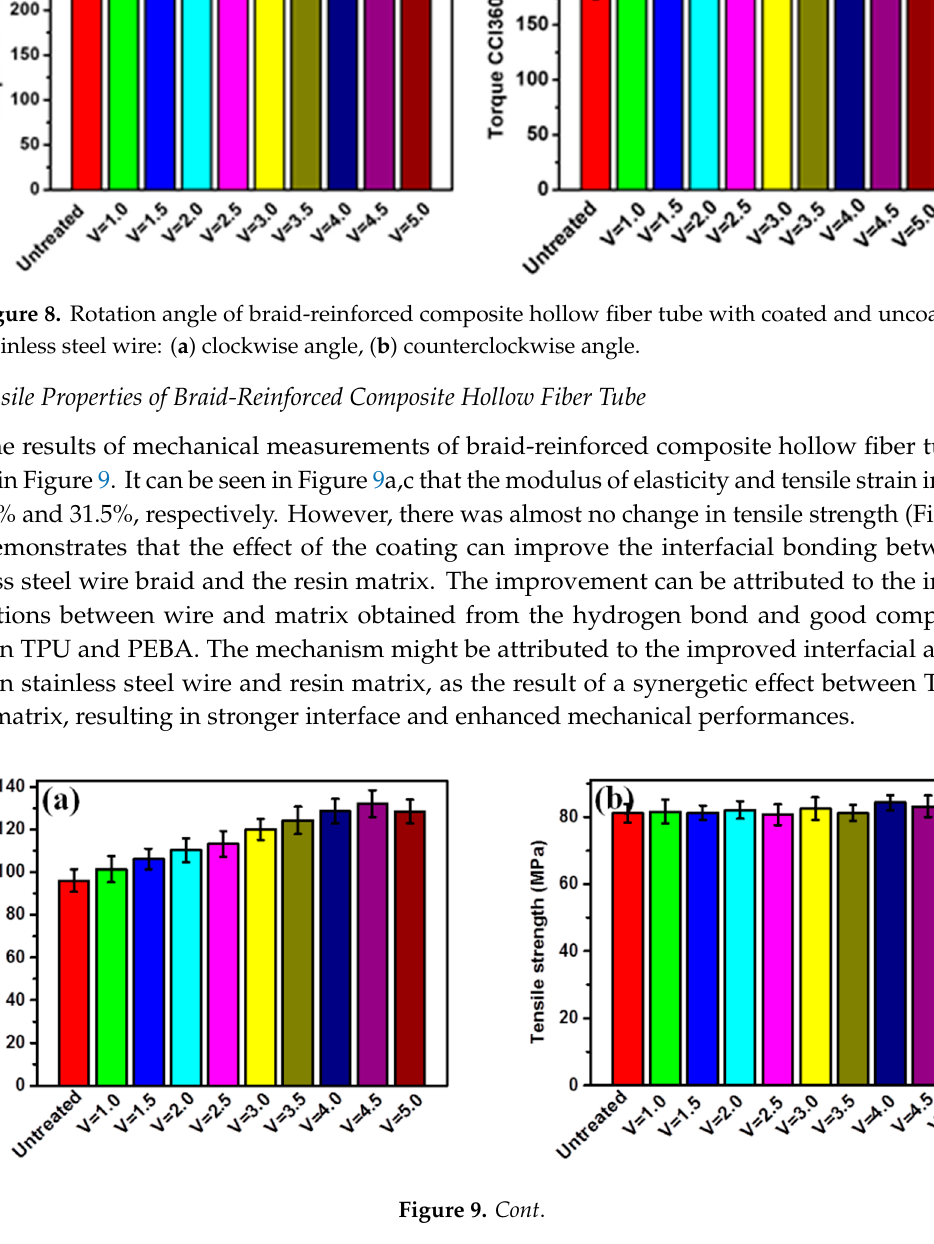
Figure 9. Tensile properties of braid-reinforced composite hollow fiber tubes with different coating speeds and uncoated stainless steel wires: ( a ) modulus of elasticity, ( b ) tensile strength, ( c ) tensile strain. 3.7. Morphology of Braid-Reinforced Composite Hollow Fiber Tube Figure 10 shows the tensile morphology of braid-reinforced composite hollow fiber tubes with coated and uncoated stainless steel wires measured by microscope. It can be seen from Figure 8b that the coated stainless steel wire did not undergo severe distortion. This is because the resin is tightly bonded to the wire to ensure the synchrony of tensile deformation. Uncoated wires were loose and bent after drawing. Therefore, the interfacial adhesion between the uncoated stainless steel wires and the resin matrix was poor. These results indicate that the interfacial adhesion of the stainless steel wire after coating with TPU and the resin matrix was greatly improved.